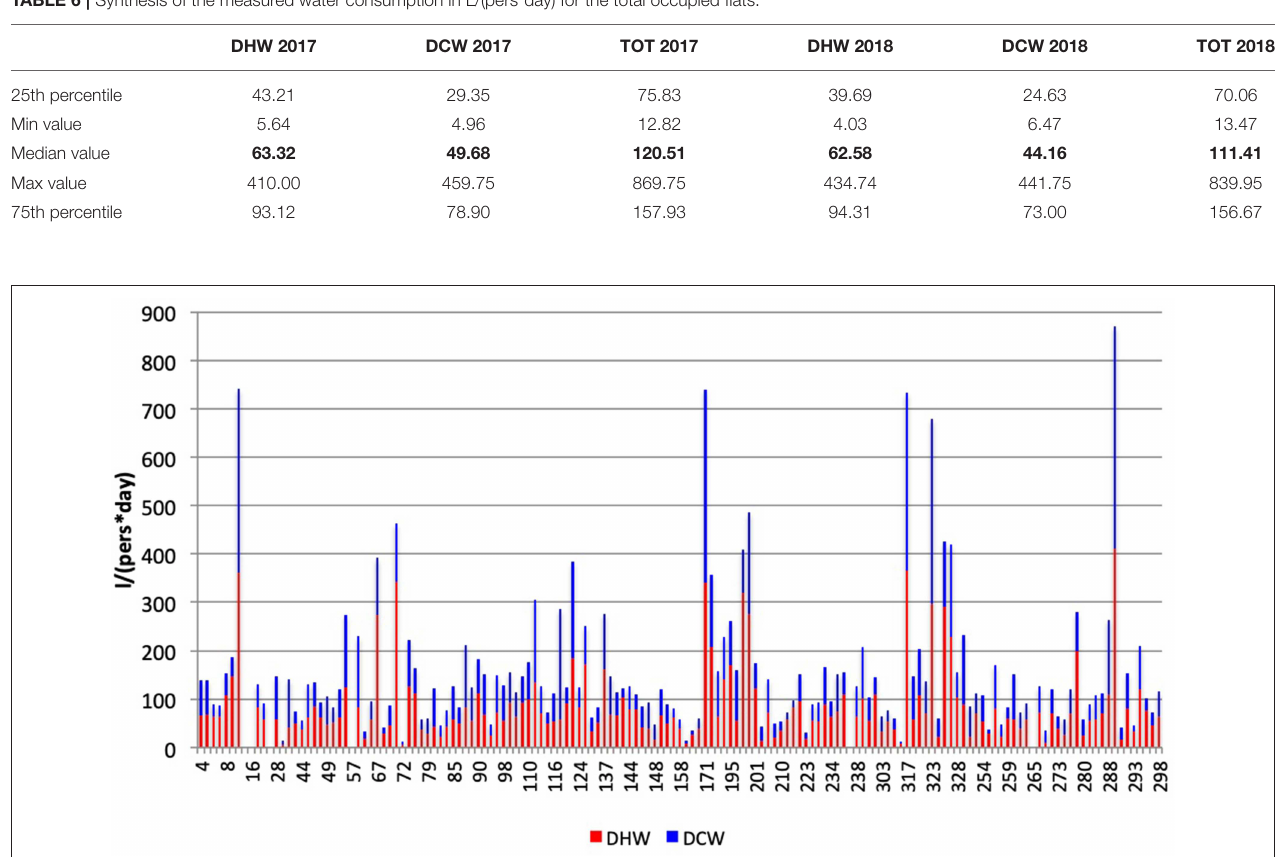
TABLE 6 | Synthesis of the measured water consumption in L/(pers*day) for the total occupied flats.